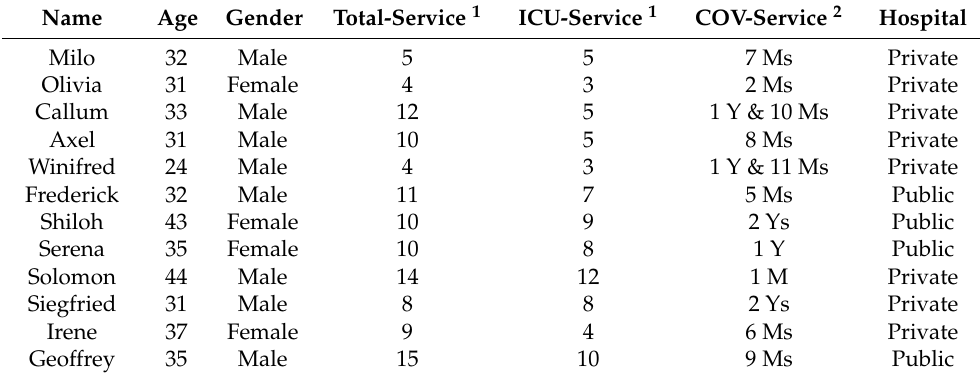
Table 1. Participants of the